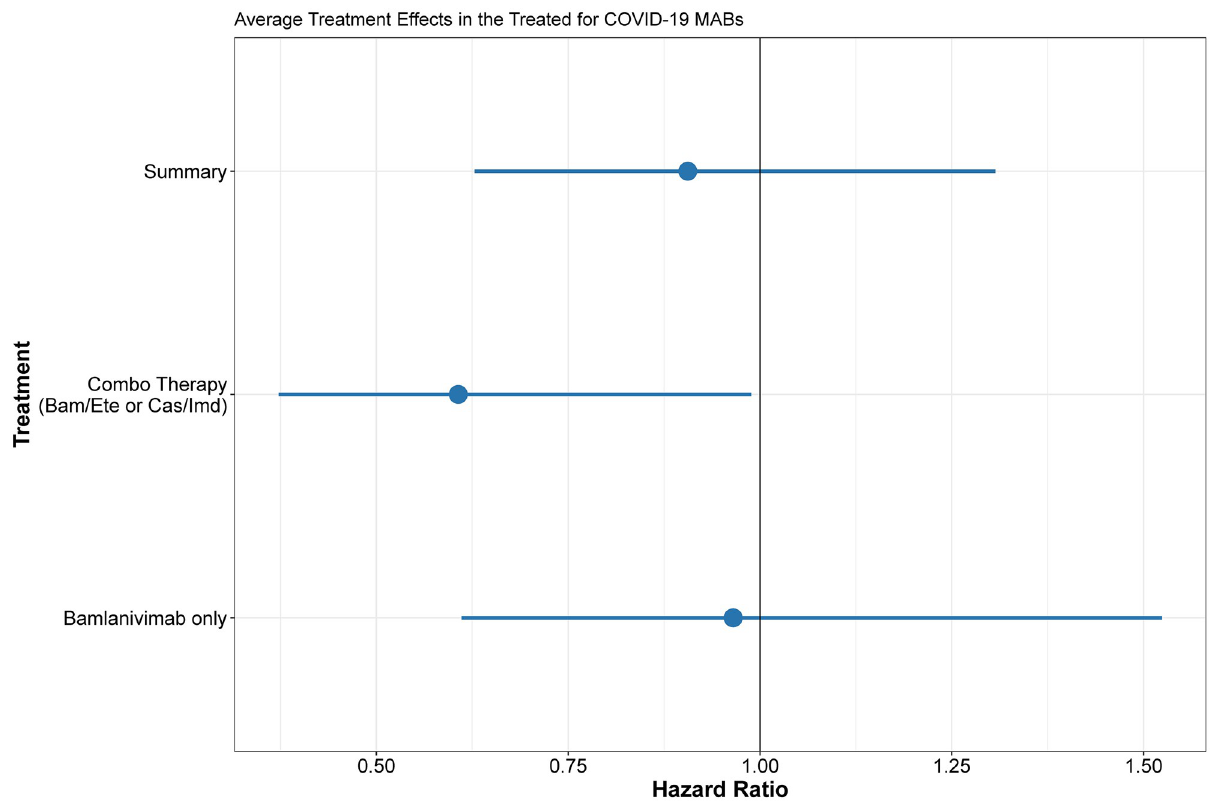
Fig 2. Estimated average treatment effects in the treated (ATT) for pooled, combo therapy only, and bamlanivimab Cox proportional hazards models. Observations in each cox model weighted by estimated propensity score from first stage logistic regression. Error bars represent 95% confidence